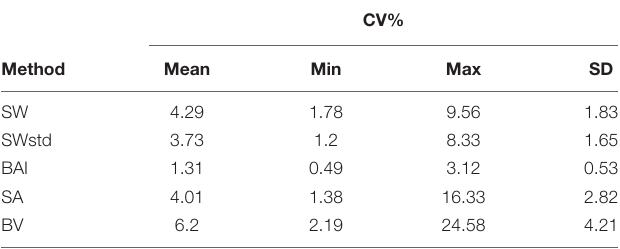
TABLE 3 | Comparison of metric precision.